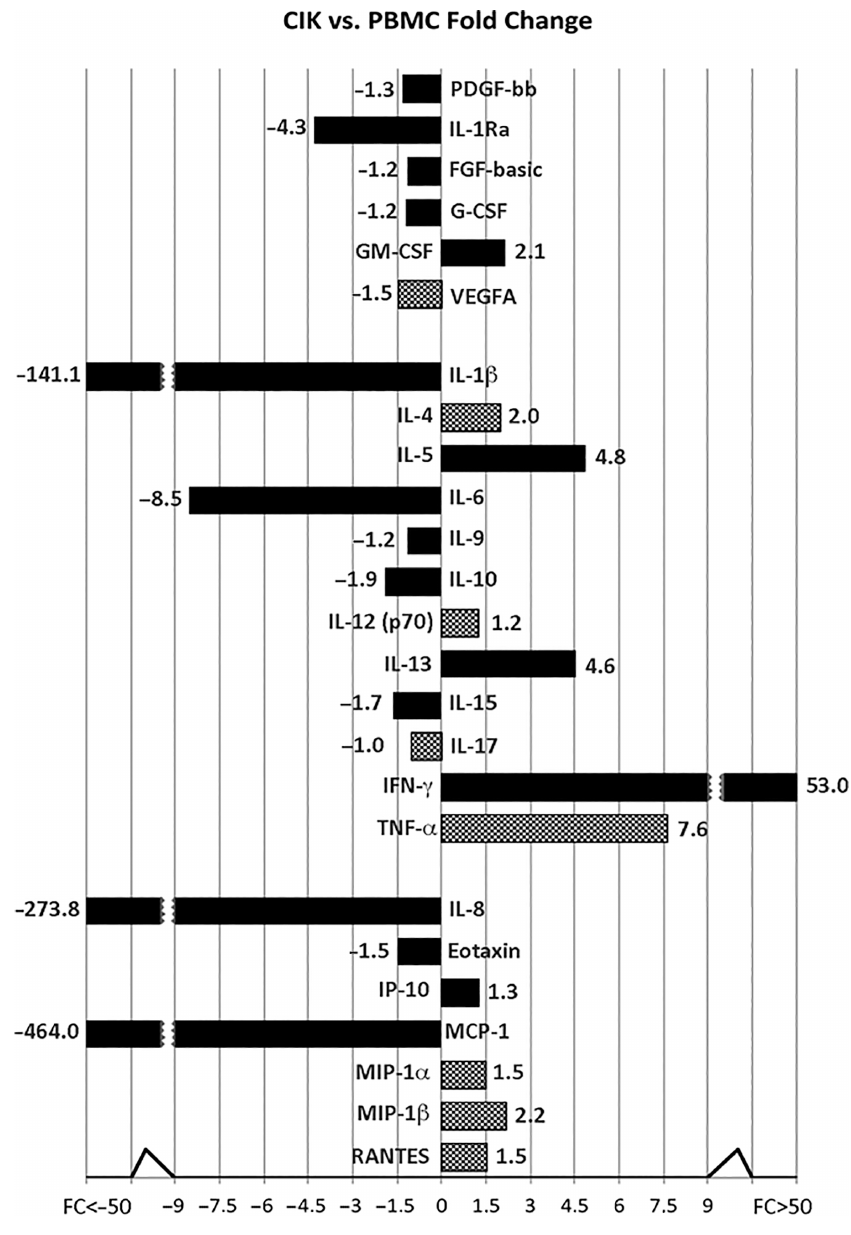
Figure 5. Gene expression profile of CIK cells and correspondence with secretome. mRNA expression was analyzed in PBMCs (d 1) and CIK cells (d 14). Protein levels of secreted proteins previously analyzed by the Bio-Plex platform were compared with the corre- sponding mRNA expression profile. The black blocks display the mRNA expression data that confirm the secretome analysis results. Instead, the chess pattern displays mRNA expression data that are inconsistent with secretome